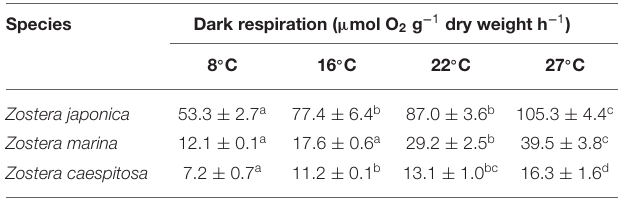
TABLE 1 | Whole-plant dark respiration rates of the three Zostera species at four water temperatures.